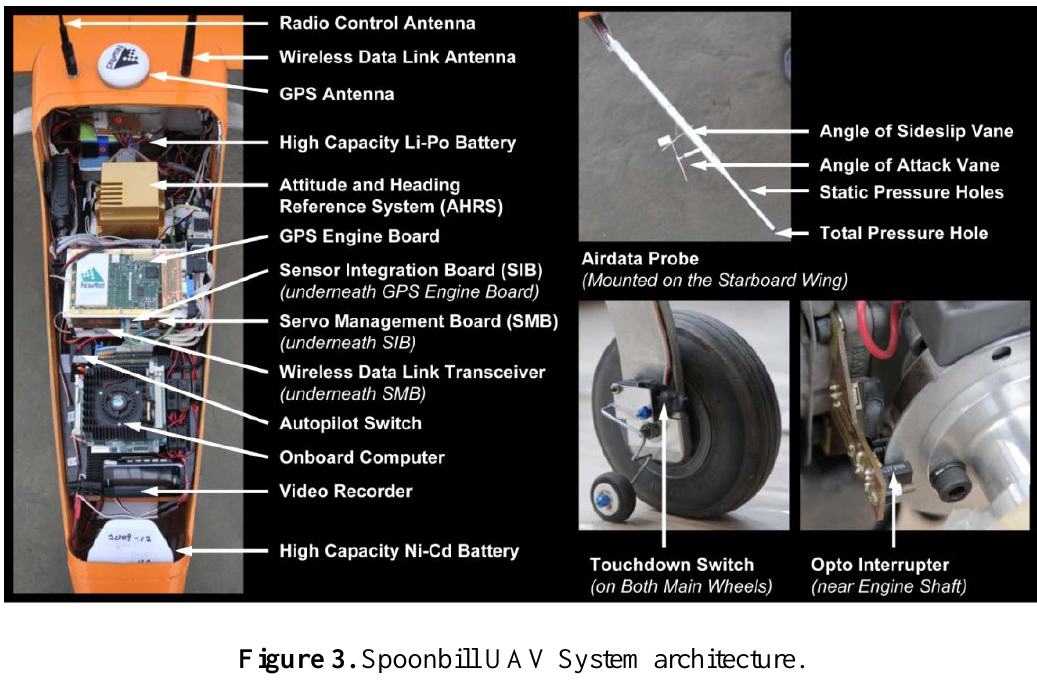
Figure 2. The onboard system.